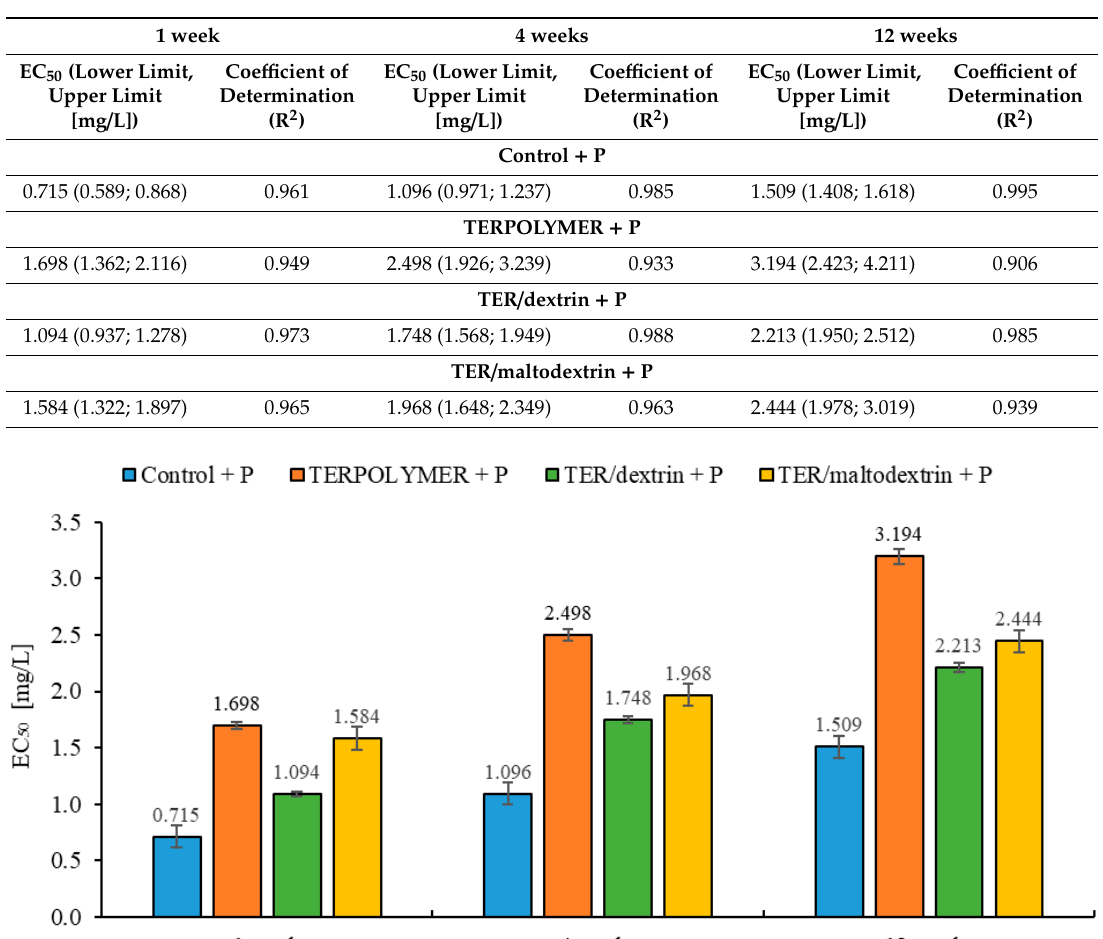
Table 7. Microtox ® EC 50 values (mg/L) of exposure of the luminescent marine bacteria A. fischeri to tested soil with microspheres (TERPOLYMER, TER/dextrin, TER/maltodextrin) with pendimethalin respective to 95% confidence limits (in brackets) obtained in the fit of the data.